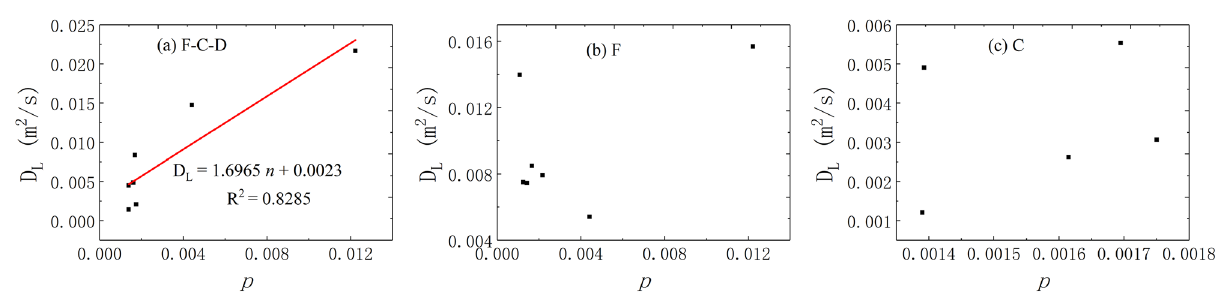
Figure 13. The correlation between the V and D L in different flow condition.